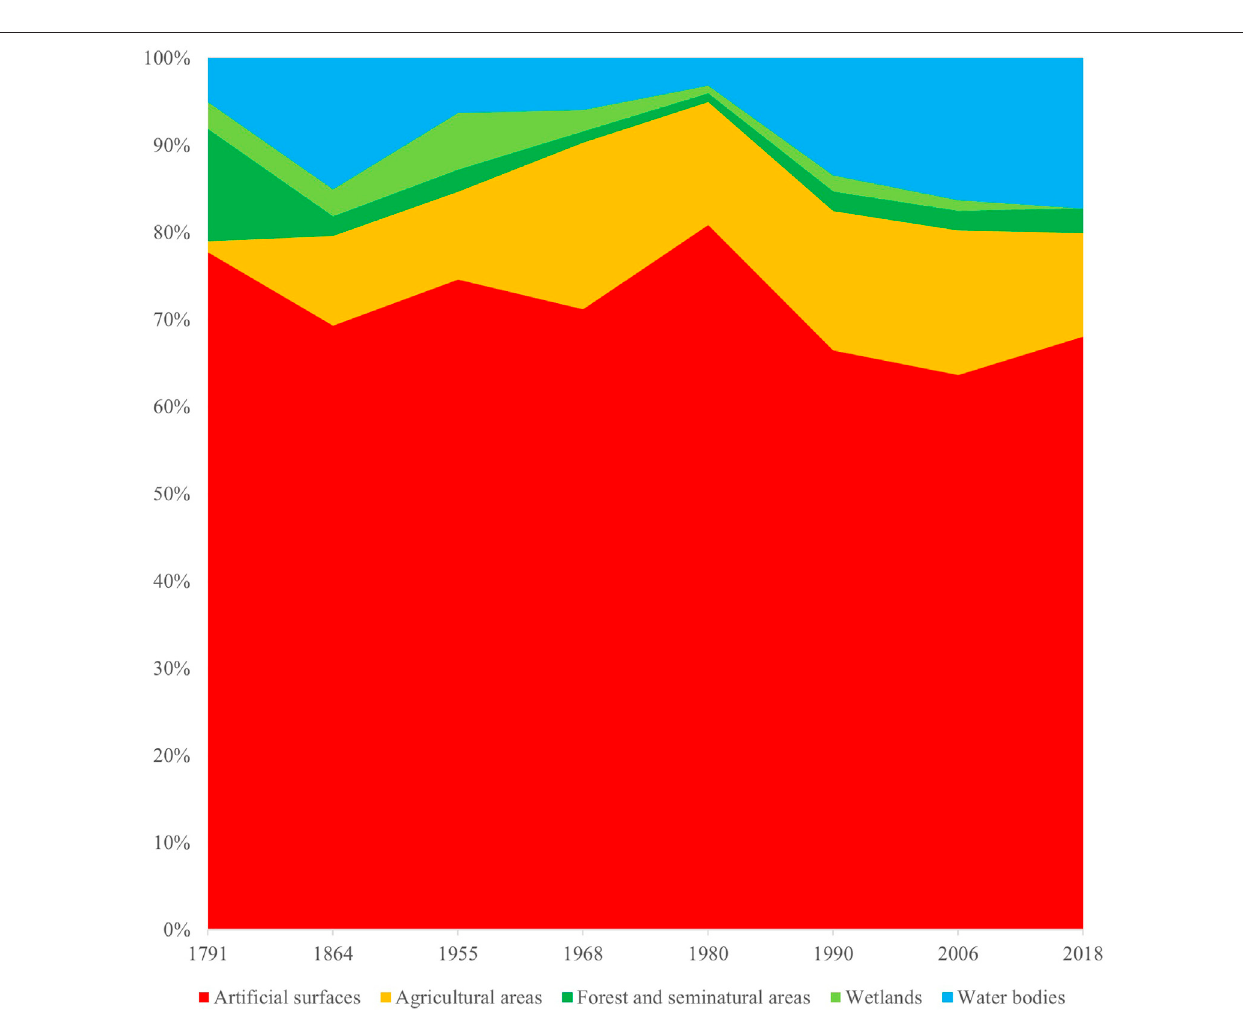
FIGURE 9 | Distribution percentage sites according to land use (1791 –